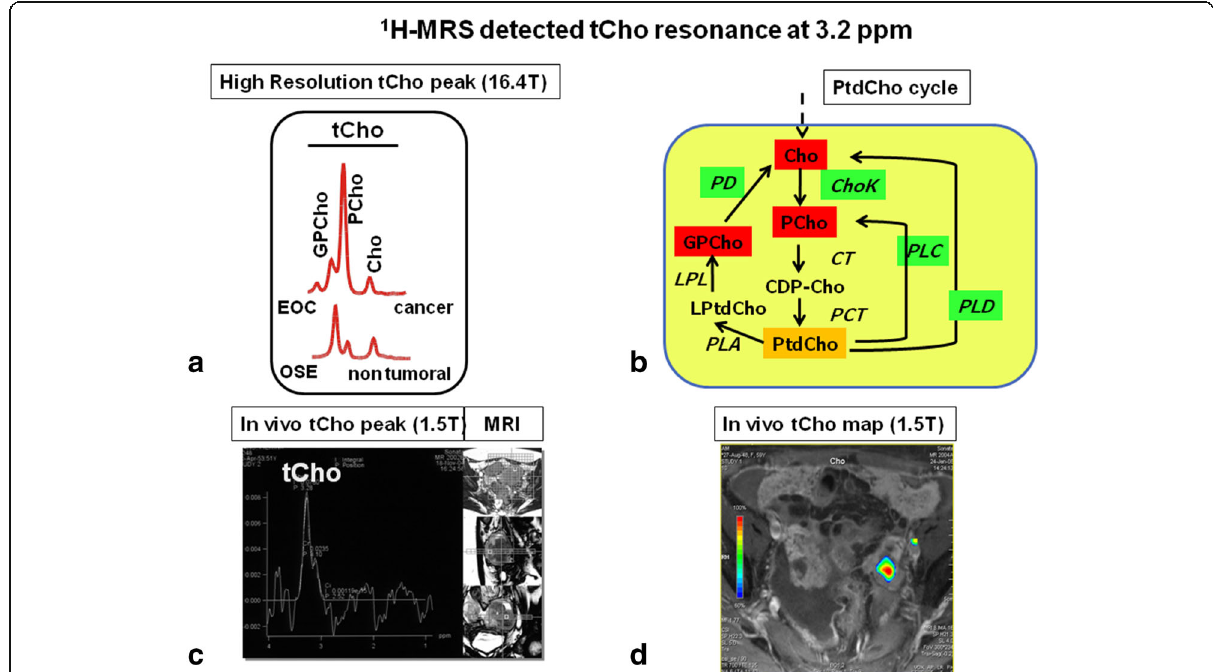
Fig. 4 In vitro 1 H-MRS detection of total choline (tCho) metabolic profile in epithelial ovarian cancer (EOC) cells and in vivo MRS/MRS imaging clinical examinations of an EOC patient. a High-resolution 1 H-MRS tCho profile of aqueous extracts of ovarian surface epithelial (OSE) and epithelial ovarian cancer (EOC) cells. b Scheme of phosphatidylcholine metabolism. c In vivo single-voxel 1 H-MRS tCho peak in a EOC patient. d In vivo 1 H-MRSI tCho map in the same EOC patient as in c . Details in references [44 – 46, 49]. Enzymes: ChoK , Choline kinase (EC 2.7.1.32); CT , Cytidylyltransferase (EC 2.7.7.15); LPL , Lysophospholipase (EC 3.1.1.5); PCT , Phosphocholine transferase (EC 2.7.8.2); PD , Glycerophosphocholine phosphodiesterase (EC 3.1.4.2); PLA , Phospholipase A1 (EC 3.1.1.32); PLA2 , Phospholipase A2 (EC 3.1.1.4); PLC , Phosphatidylcholine-specific phospholipase C (EC 3.1.4.3); PLD , Phospholipase D (EC 3.1.4.4). Metabolites: CDP-Cho , Cytidine diphosphate-choline; Cho , Free choline; GPCho , Glycerophosphocholine; LPA , Lysophosphatidate; LPtdCho , Lysophosphatidylcholine; PCho , Phosphocholine; PtdCho , Phosphatidylcholine; tCho , Total choline-containing metabolites (GPCho + PCho + Cho). Adapted with permission from Podo et al.